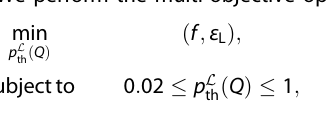
Fig. 7 Restoring code performance by post-selecting on leakage detection. Improvement in the logical error rate ε L via post-selecting on the detection of leakage for a MWPM decoder (green) and the decoder upper bound (red). The post-selection is based on the probabilities predicted by the HMMs (solid) or on those extracted from the density-matrix simulation (dashed), for 2 × 10 4 runs of 20 QEC cycles each. The physical error rate of a single transmon qubit under decoherence is also given (solid black). Detection of leakage allows for the restoration of the performance of the MWPM decoder, reaching the memory break-even point by discarding about ≈ 28% of the data. The logical error rates obtained from simulations without leakage (and without post-selection) are indicated by